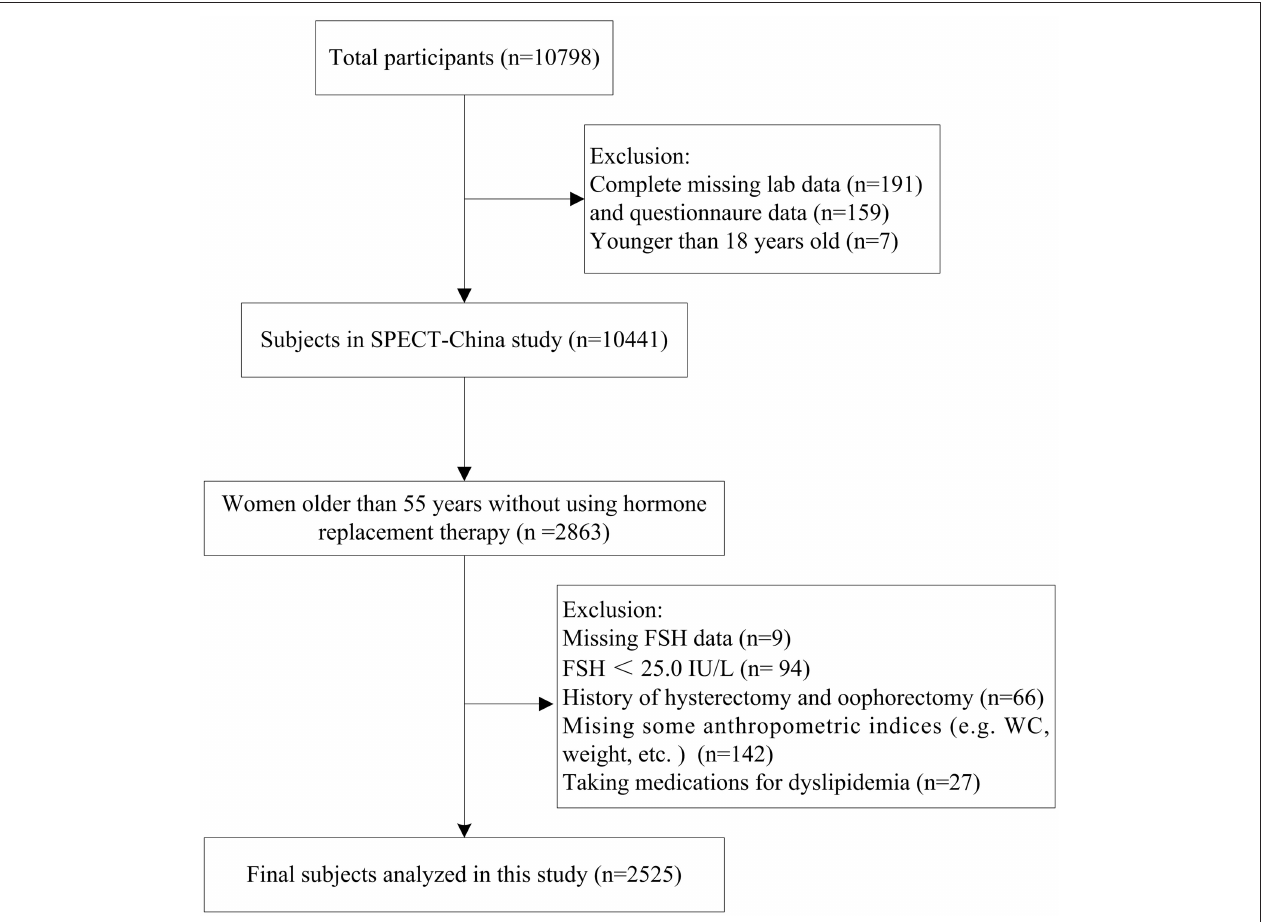
FIGURE 1 | Flowchart of postmenopausal women selected from